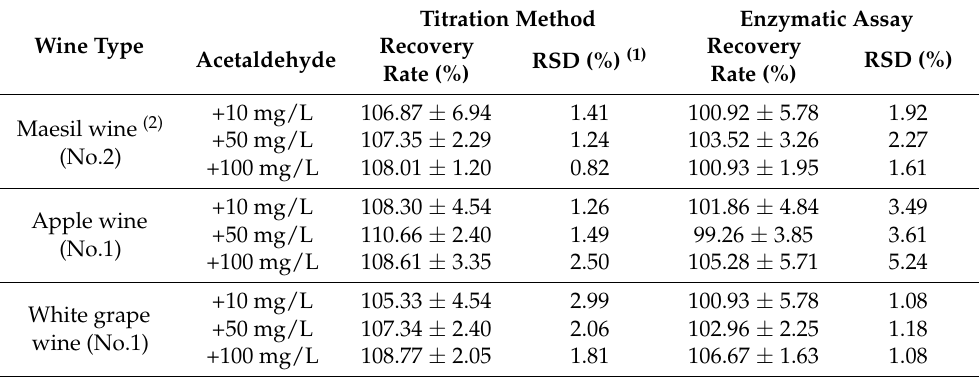
Table 5. Comparison of accuracy and precision of acetaldehyde analysis between titration method and enzymatic assay. Titration Method Enzymatic Assay Wine Type Recovery Acetaldehyde RSD (%) Rate (%)